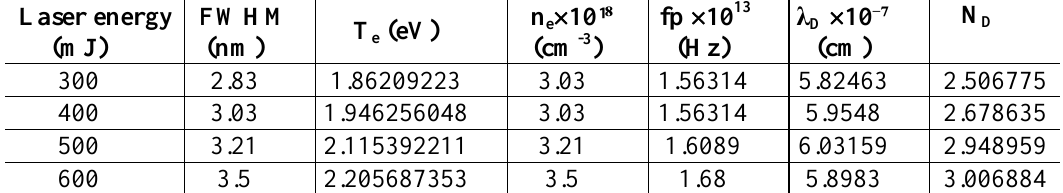
Table 3: Plasma parameters for Indian costus with different laser energies in the air. Laser